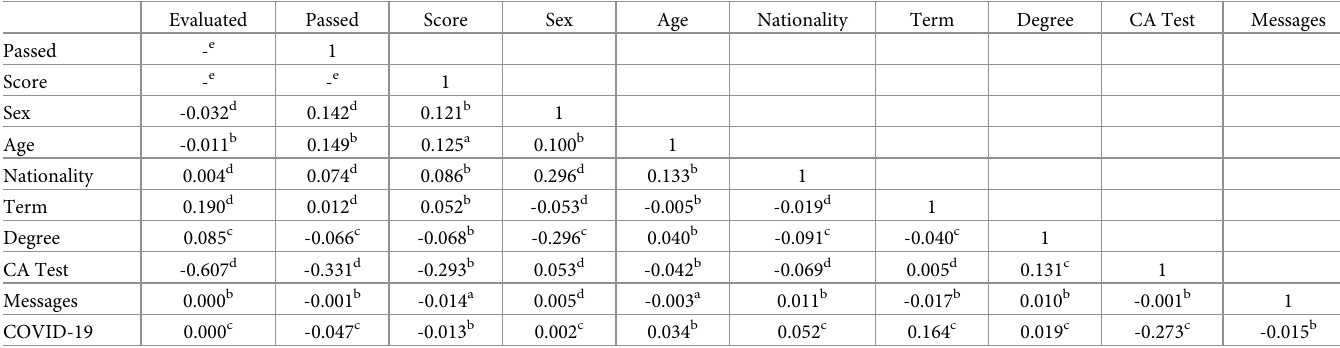
Table 5. Correlations.